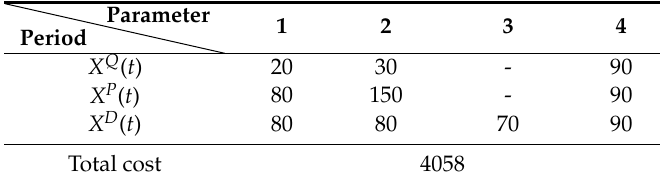
Table 5. The Total cost of integrated manufacturing functions as Optimum result.